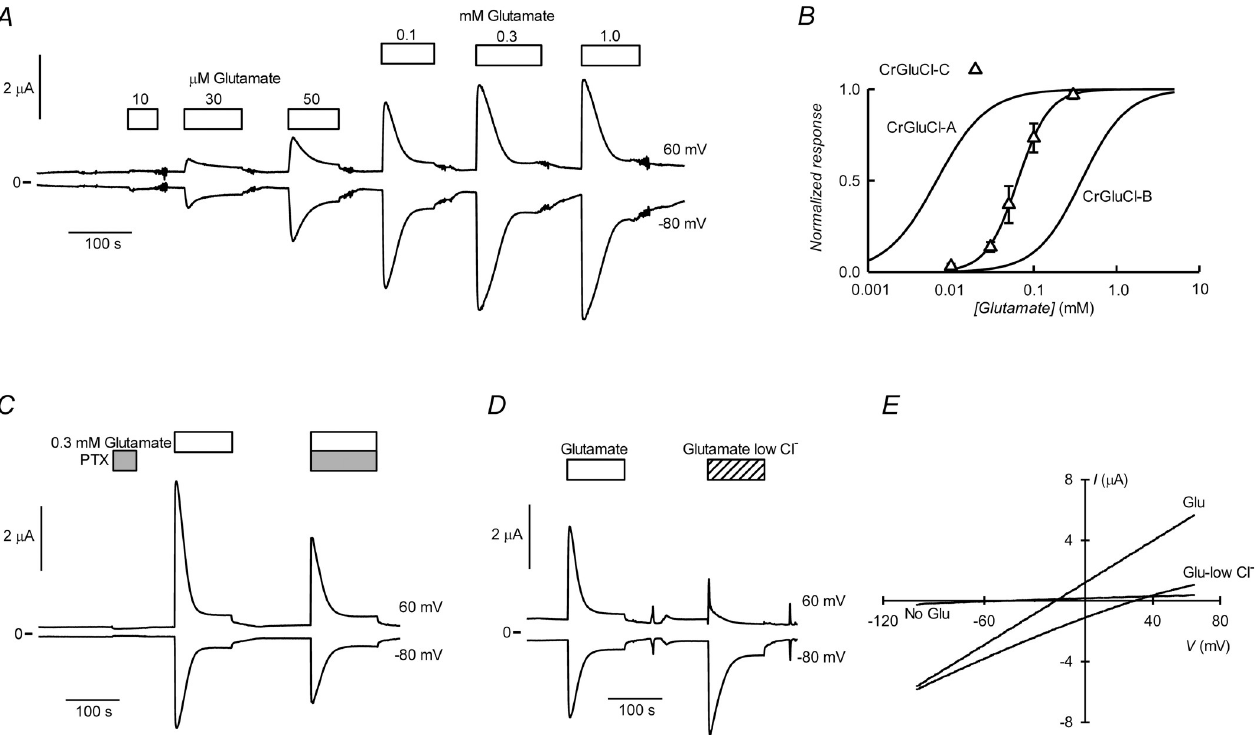
Fig 5. Glutamate-evoked currents in oocytes injected with CrGluCl-C cRNA. A. Current traces obtained at the indicated membrane potentials during bath application of increasing glutamate concentrations as indicated by the boxes. B. Plot summarising results of the concentration-response relationship of the glutamate-sensitive current mediated by CrGluCl-C (means ± SD, n = 6). C. Effect of 100 μ M PTX on the glutamate-dependent current of an oocyte expressing CrGluCl-C. D. Current traces obtained at the indicated membrane potentials during bath application of 0.3 mM glutamate with normal and low extracellular chloride concentration as indicated by the boxes. E. The respective current-voltage relations taken from voltage-ramps applied during experiment in D are shown.